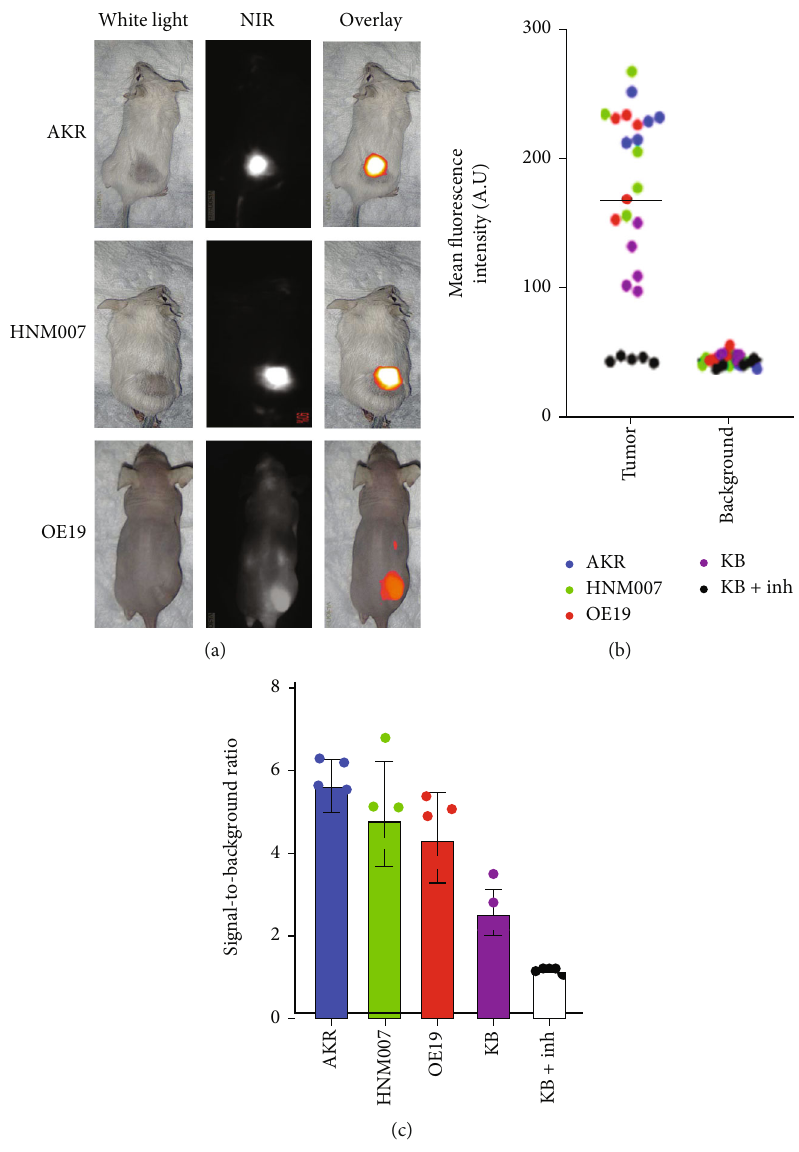
Figure 5: VGT-309 labels esophageal cancer allografts and xenografts. (a). Representative bright fi eld, near-infrared (NIR) and overlay images of mice bearing various esophageal cancer fl ank tumors ( n = 3 /cell line) 24 hours after injection of 2mg/kg VGT-309. Mice bearing KB fl ank xenografts ( n = 3 ) pretreated with 50mg/kg JPM-OEt via intraperitoneal injection for 5 days before VGT-309 administration served as a negative control and those pretreated with delivery vehicle ( n = 3 ) served as a positive control. (b). Mean fl uorescent intensity (MFI) of tumor and background tissue with symbol color indicating cell line. (c). Signal-to-background ratios (SBRs) from the fl ank tumors. Each point represents a single tumor with means and error bars displayed for each